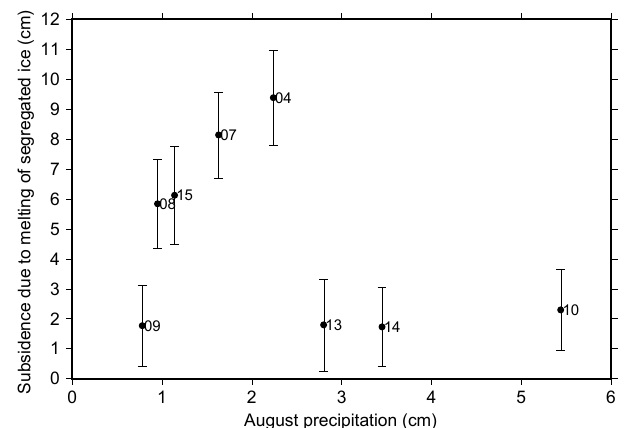
Figure 6. Scatter plot between the estimated subsidence due to the melting of segregated ice in the active layer and the precipitation in the previous August. The labels refer to the year of the subsidence.